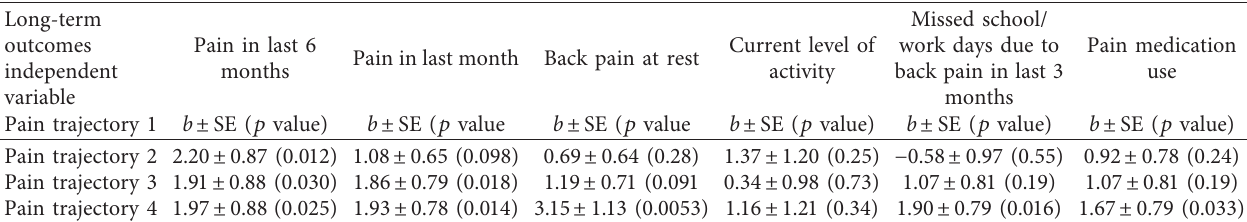
Table 5: Prediction of long-term